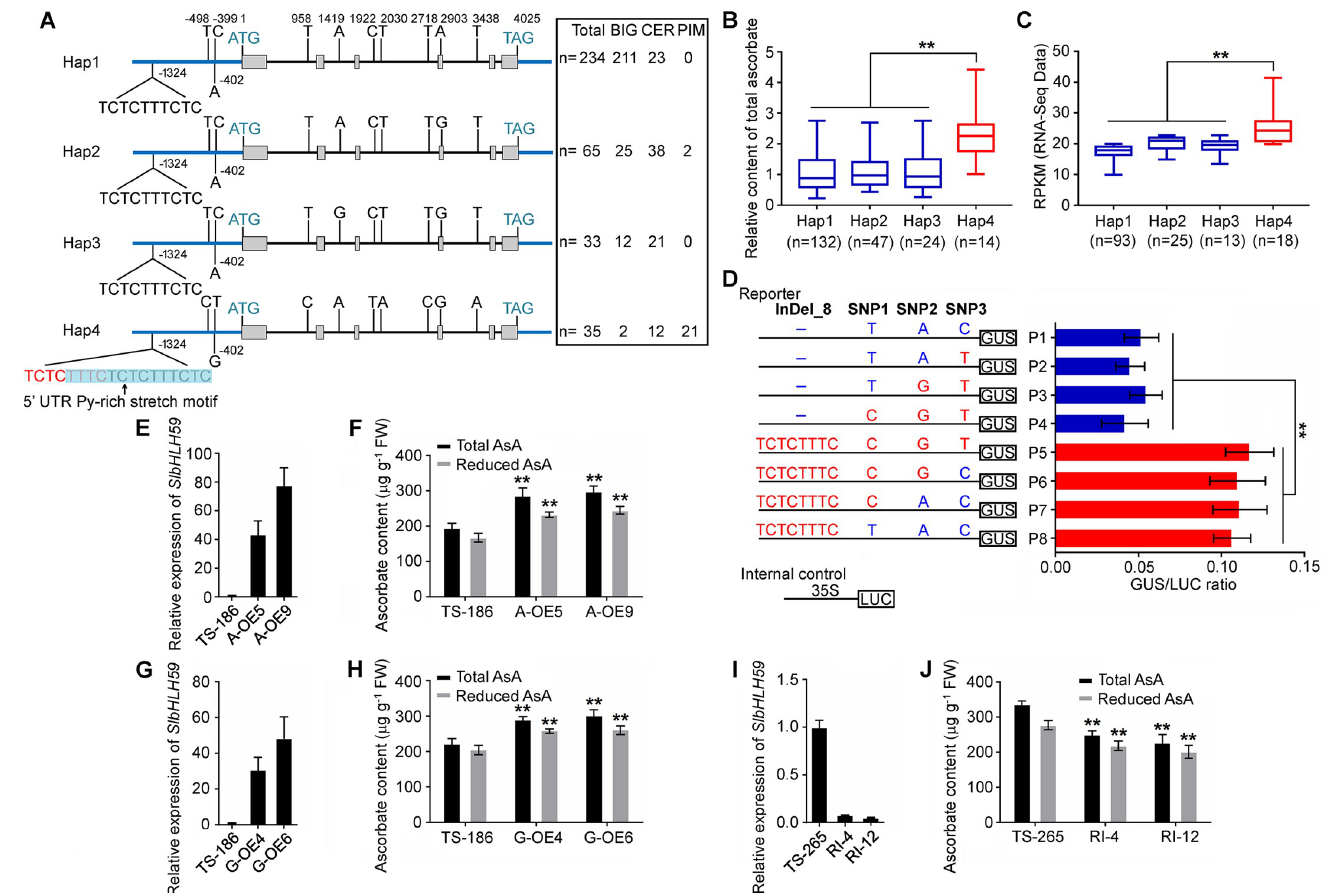
Fig 3. Haplotype and functional analysis of SlbHLH59 in tomato. (A) Structural variations of the four SlbHLH59 haplotypes. Blue represent the promoter and 3’ UTRs, grey boxes represent coding sequences and the line between the grey boxes represents the intron. The 11 nucleotide polymorphisms are indicated at their corresponding positions. Four haplotypes of SlbHLH59 are examined in 367 tomato accessions. (B, C) The relative ascorbate content (B) and expression of SlbHLH59 (C) in fruits of four SlbHLH59 haplotypes. (D ) Transient expression assay of promoter activity in Arabidopsis protoplasts. The SlbHLH59 promoter fragments were inserted into the reporter vector (pCAMBIA1304-GUS). Both vectors of reporters and internal control (pGreen II 0800, 35S+LUC) were transformed into Agrobacterium cells and used for Arabidopsis protoplast transformation. Left, constructs with site-directed mutations at the four polymorphisms in the promoter region. Right, relative GUS/LUC values. Values are represented as means ± SD (n = 3). (E, G, I) The relative expression of SlbHLH59 in SlbHLH59 SNP9A overexpression (E) SlbHLH59 SNP9G overexpression (G) and SlbHLH59 RNAi (I) transgenic tomato lines. (F, H, J) The ascorbate content in SlbHLH59 SNP9A (F) SlbHLH59 SNP9G (H) and SlbHLH59 RNAi (J) transgenic tomato lines. The background of SlbHLH59 overexpression and RNAi transformation is TS-186 and TS-265 respectively. Asterisks indicate significant differences by t test: �� P < 0.01.